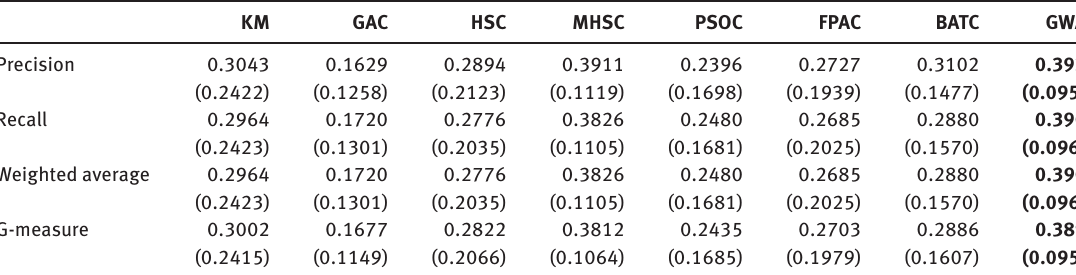
Table 4: Mean (SD) of Cluster Quality Matrices for Sph_5_2 Data Set.